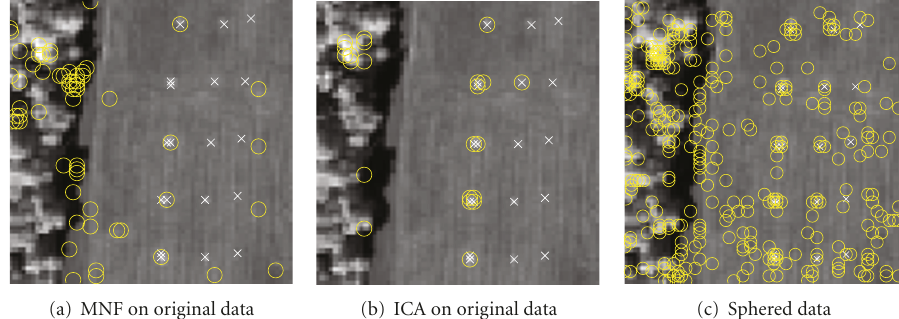
Figure 19: Endmember extraction results by PPI using 500